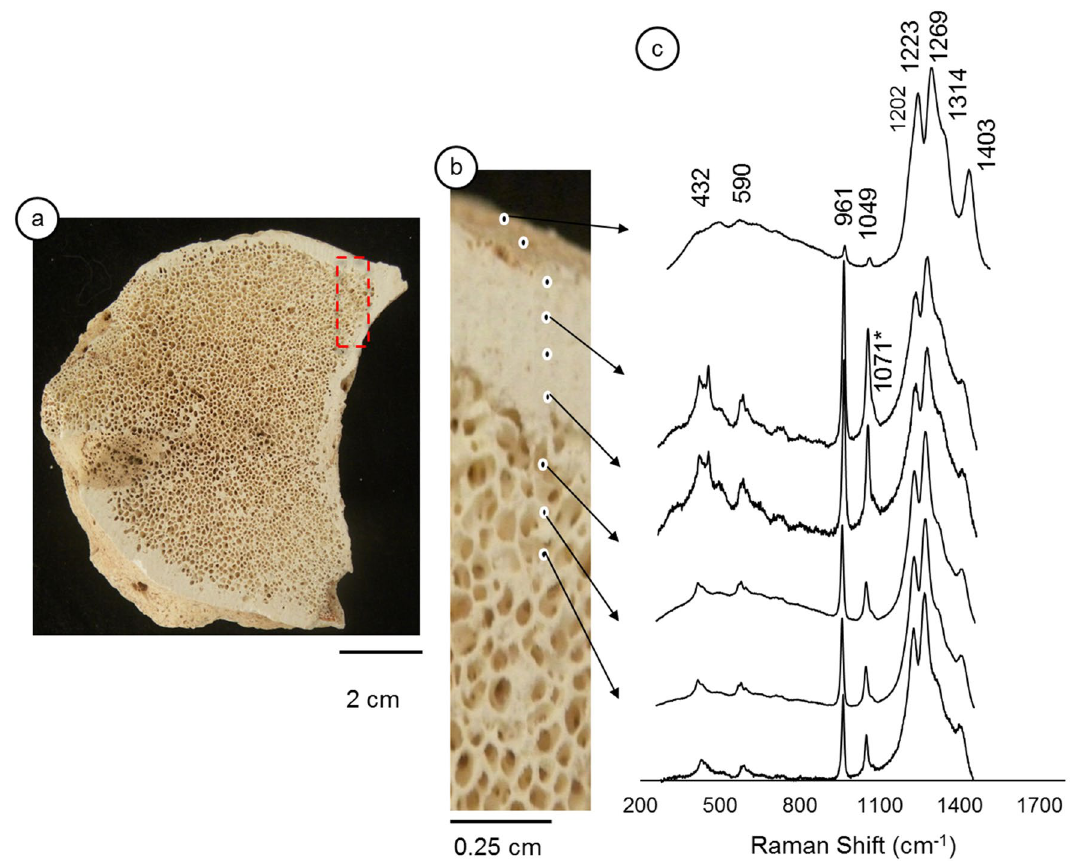
Figure 3. Internal surface of the LAPA/SBF-3-0081 sample. Figure ( a )—Red dashed box indicates the analyzed area in the sample. Figure ( b )—Details of the analyzed area and the micro-Raman measurement points. Figure ( c )—Raman spectra, where ‘*’ indicates the B-type carbonate